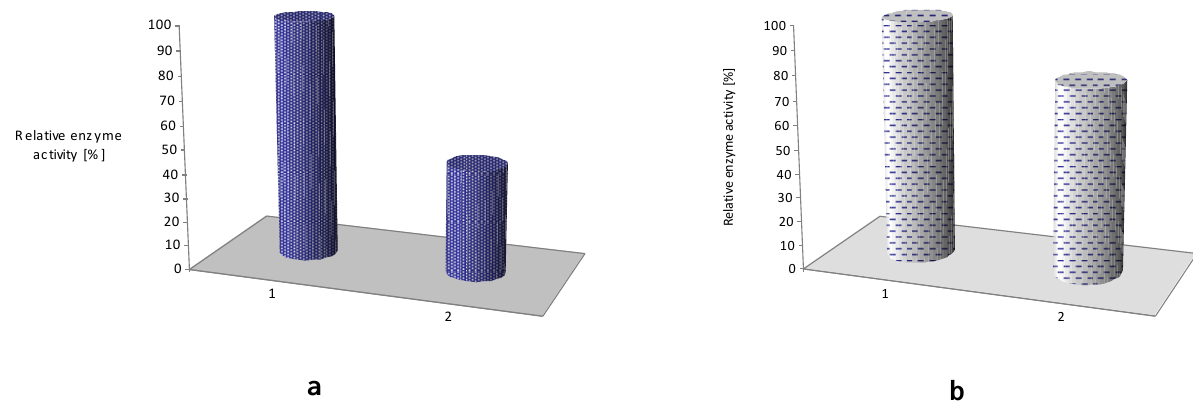
Figure 7. Activity of laccase– a [11] and glucose oxidase– b immobilized in LB/LS film, 1- with polymer as mediator ( laccase–polymer 1 , glucose oxidase–polymer 2 ), 2- without a polymer mediator.